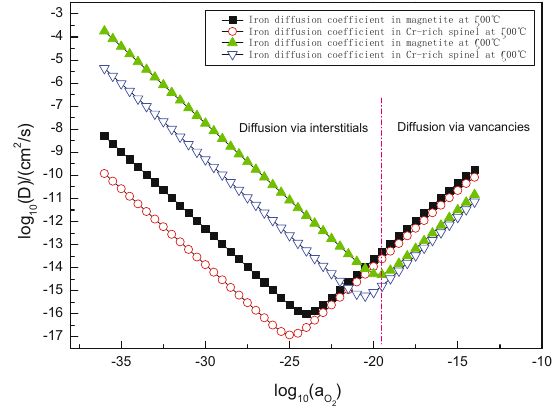
Figure 2: Iron diffusion coefficient in magnetite and Cr - rich spinel over oxygen activity at 500 and